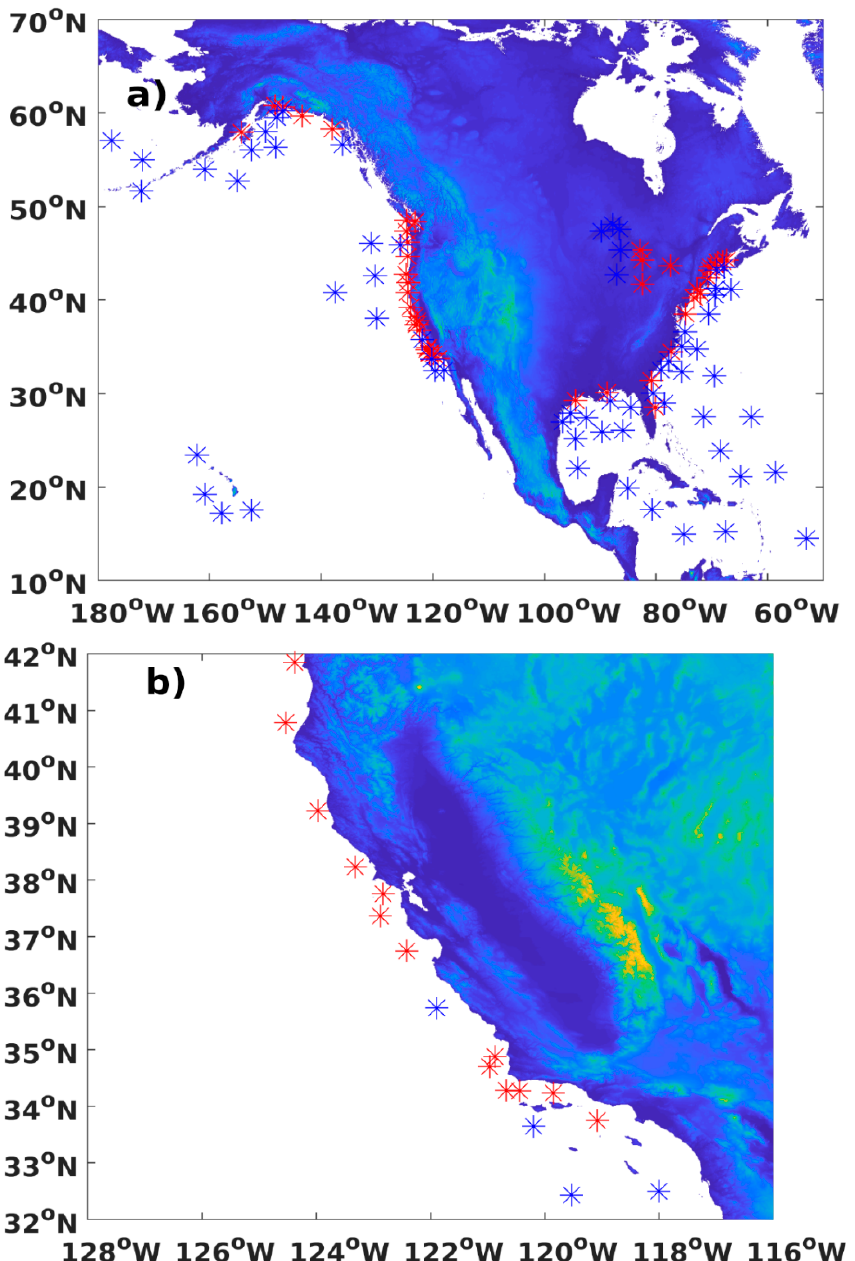
Figure 1. National Data Buoy Center (NDBC) buoy locations. Red and blue symbols show coastal (<50 km of coastlines) and offshore buoys, respectively. ( a ) Panel shows all buoy locations, while ( b ) shows only buoys located in the Californian